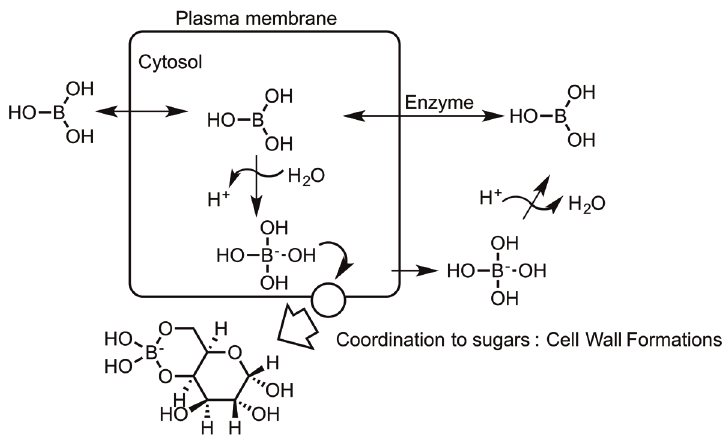
Figure 47 - Transport and absorption of borate in a